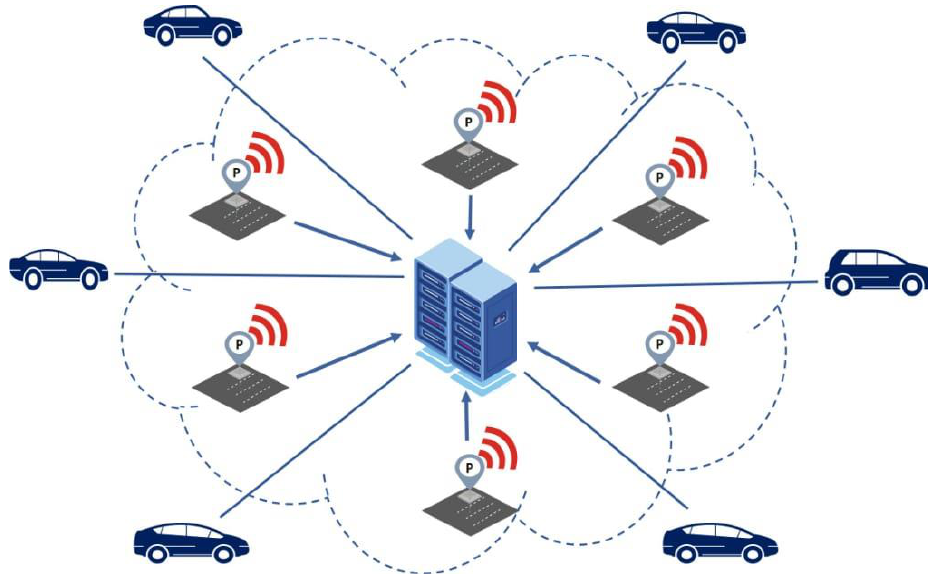
Figure 3. Smart car parking information system.